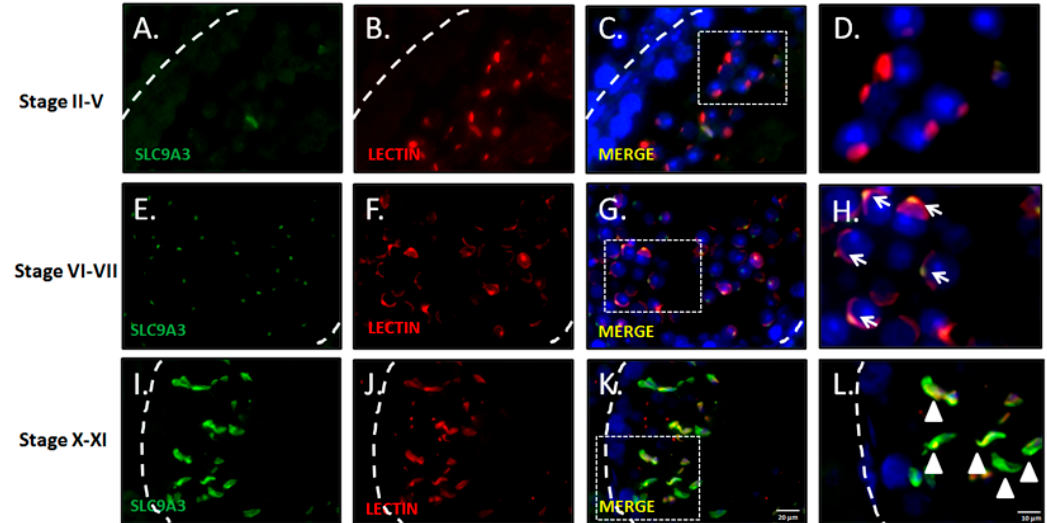
Figure 2. Expression patterns and localization of SLC9A3 during murine spermatogenesis. Top to bottom: Stages II–V ( A – D ); stages VI–VII ( E – H ); and stages X–XI ( I – L ) of spermatogenesis; ( A , E , I ) show the SLC9A3 signal ( green ); ( B , F , J ) show Lectin ( red ; acrosome marker); ( C , G , K ) merge from ( A , B , E , F , I , J ), respectively. The nucleus was stained using DAPI ( blue ). The enlarged Figure of ( C , G , K ) are shown in Figures ( D , H , L ), respectively. Arrows indicate the acrosomal vesicles. Arrowheads indicate the acrosome-covered regions of sperm heads. The scale bar is 20 μ m in ( K ), and 10 μ m in ( L ).